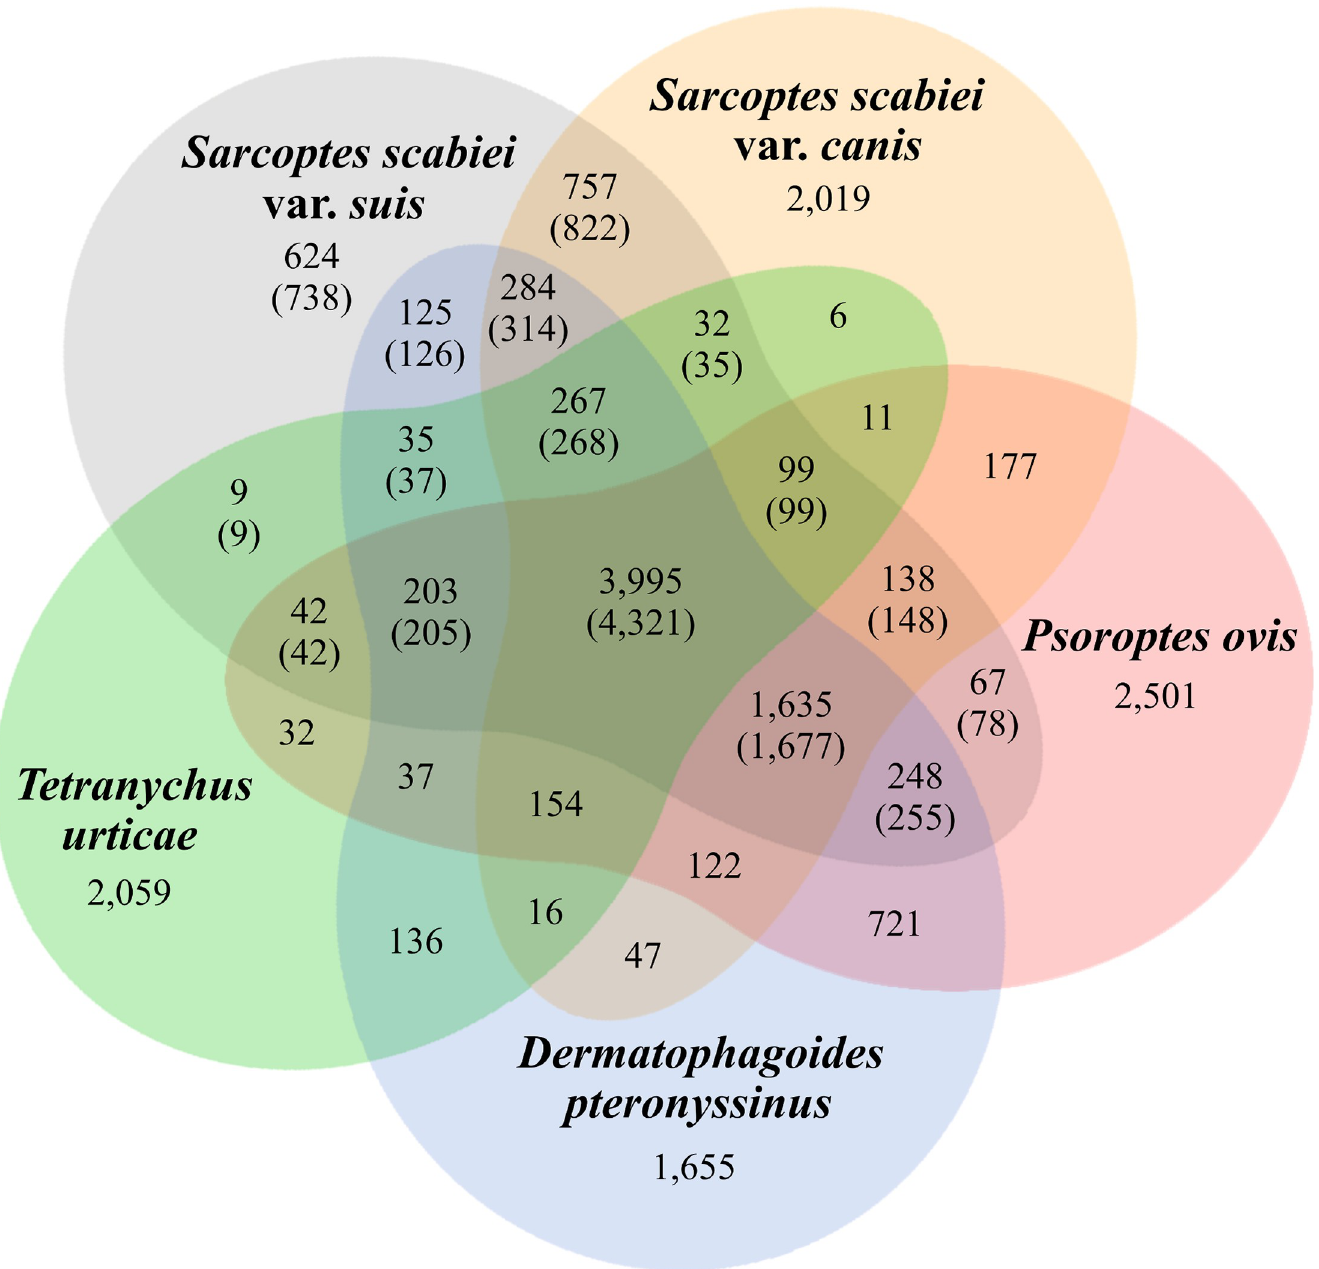
Fig 2. Comparison of orthologous proteins among selected mite species. VENN diagram showing numbers of homologous groups of proteins among Sarcoptes scabiei var. suis , Sarcoptes scabiei var. canis , Psoroptes ovis , Dermatophagoides pteronyssinus and Tetranychus urticae . Protein-coding genes of S . scabiei var. suis are indicated in parentheses. NCBI accession identifiers for the genomes of the taxa included here are: WVUK01000000, GCA_000828355.1, GCA_002943765.1, GCF_ 001901225.1 and GCF_000239435.1,